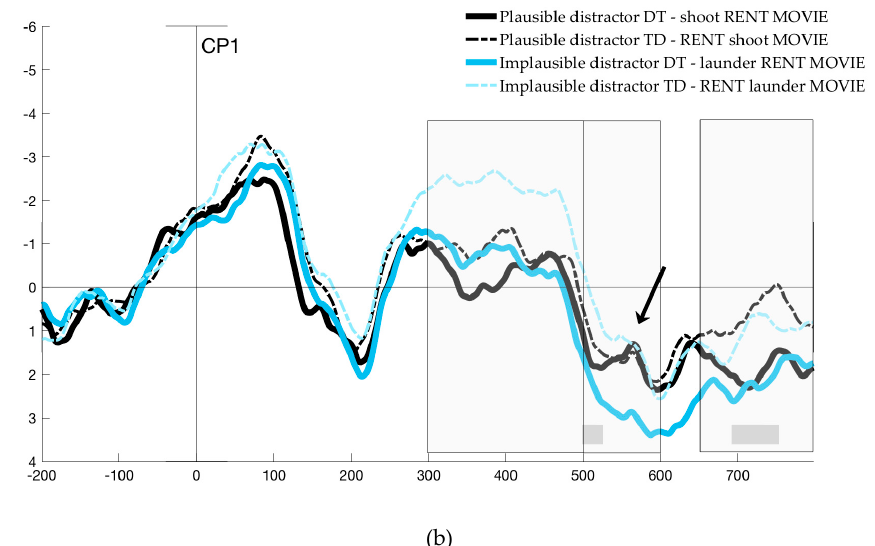
Figure 4. ERP waveforms at ( a ) FC6 (right frontocentral) and ( b ) CP1 (left centroparietal). The legend shows examples for each condition, with the target verb capitalized. Grey bars underneath show the time points of significant effects in running t -tests within the pre-defined 500–800 ms time window. Boxes show the three time windows analyzed. The arrow in (b) indicates the N inc effect. Negativity is plotted up.